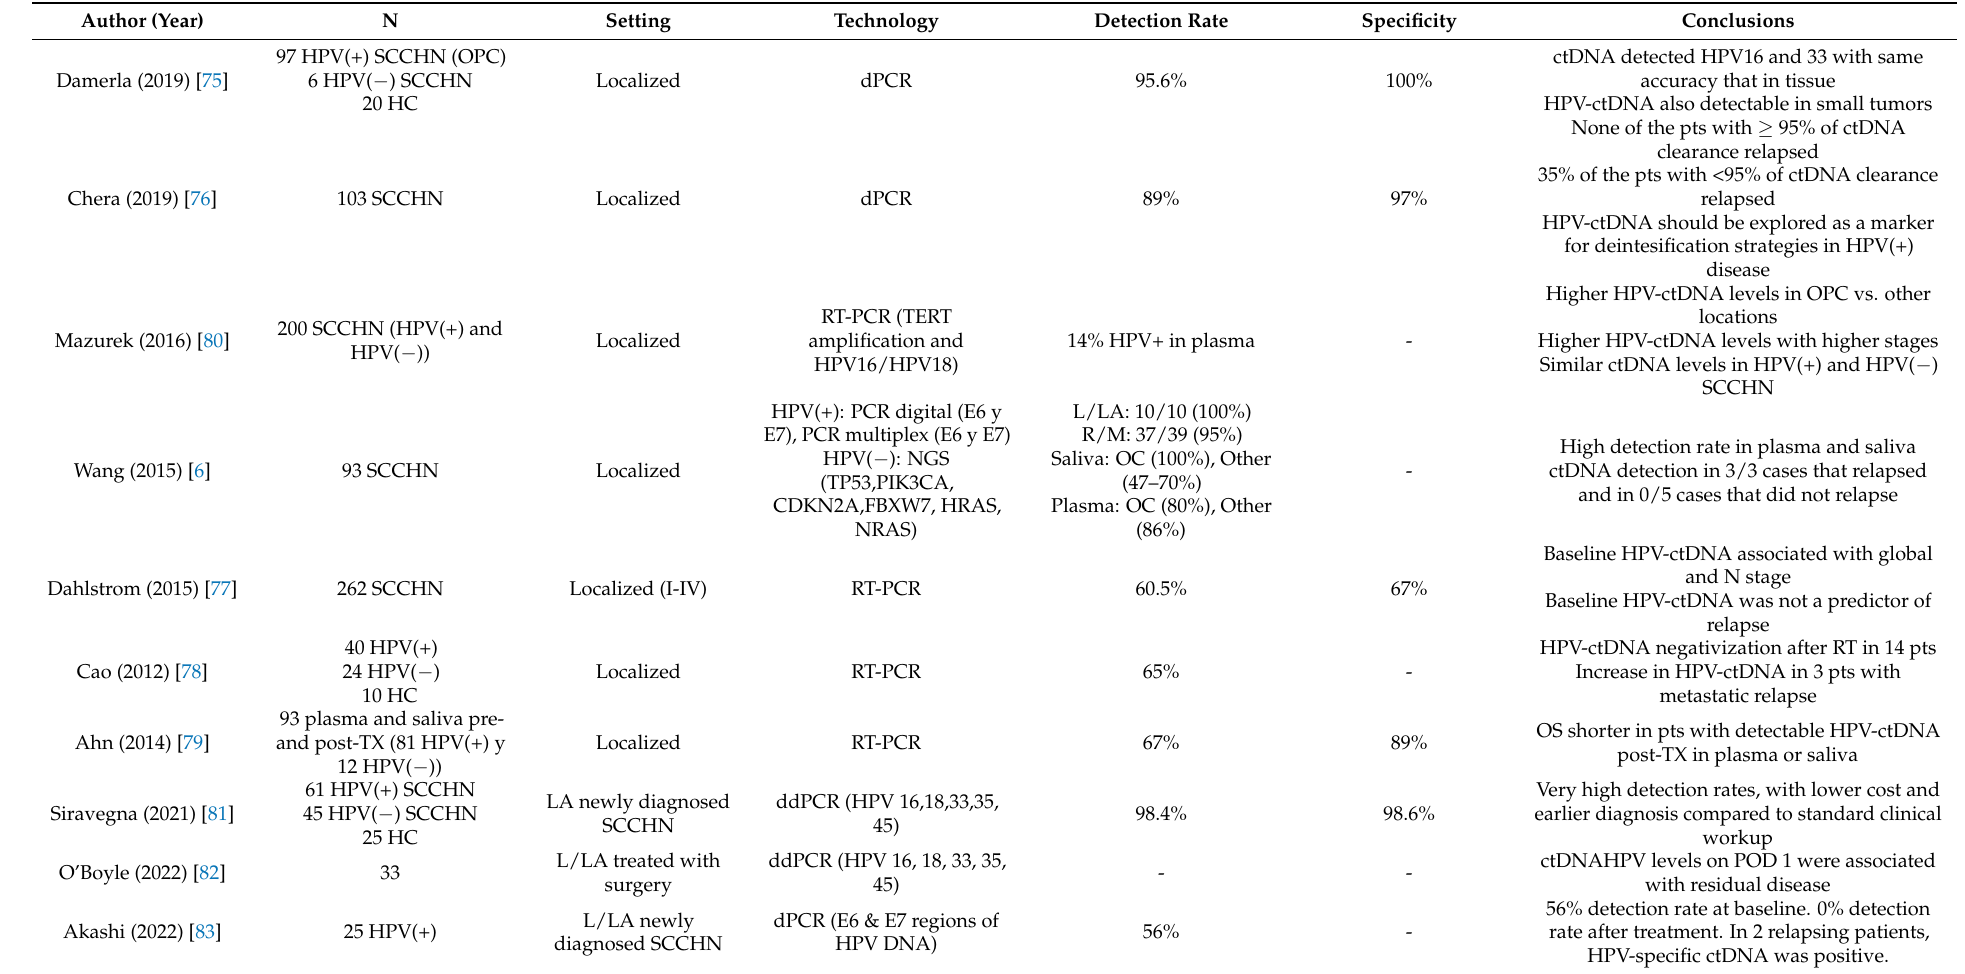
Table 4. Most relevant studies with ctDNA in patients with HPV-related